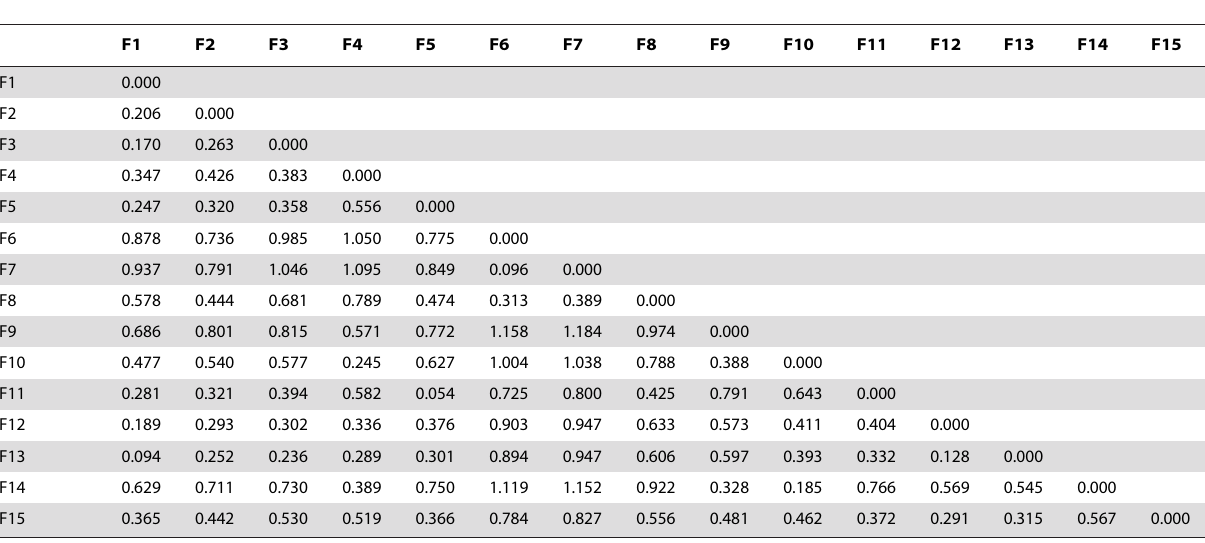
Table 5. Divergence of serum titers from 15 different farms with Distance Matrix.